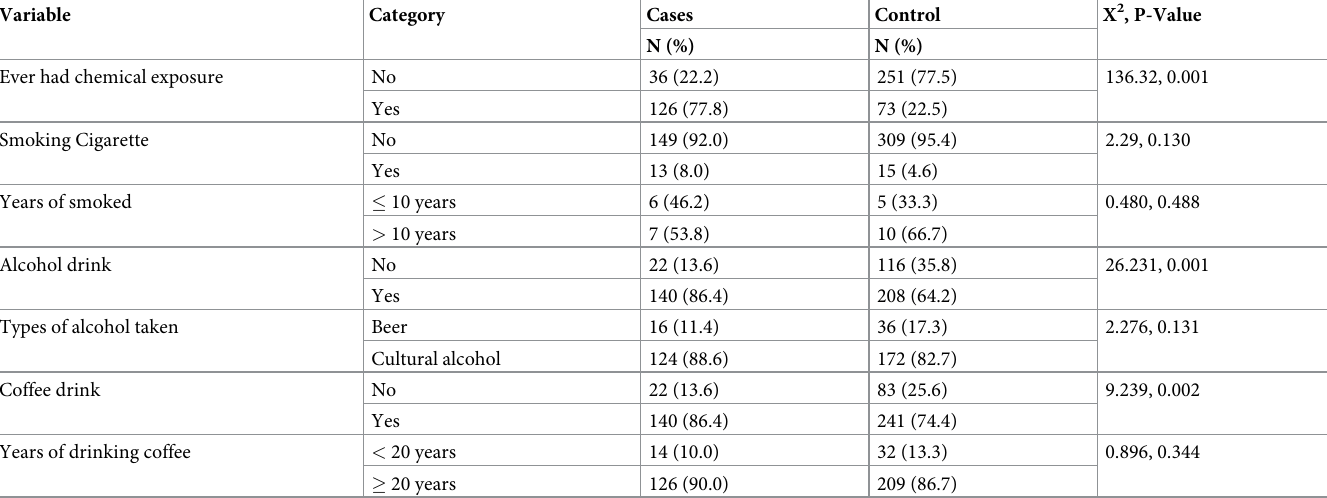
Table 3. Chemical exposure-related characteristics of the respondents at Felegehiwot specialized hospital, northwest Ethiopia,